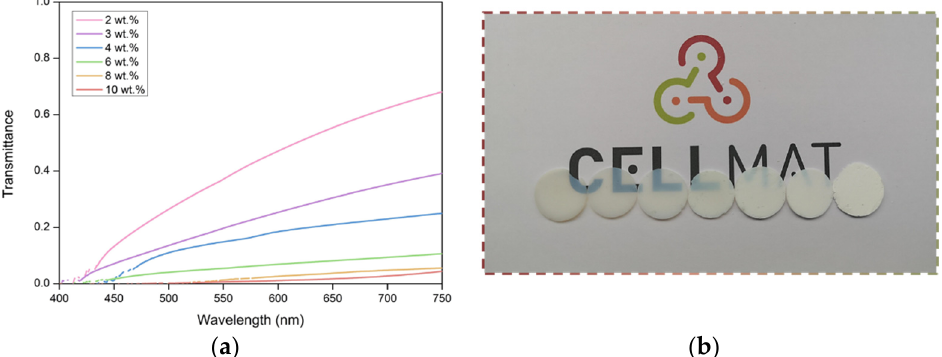
Figure 7. ( a ) UV–Vis transmittance measurements for all the samples under study. Measurement corrected for samples of 1 mm. ( b ) Optical micrographs of the samples from left to right; catalyst content and particle size increase in the following order: 2 wt.%, 3 wt.%, 4 wt.%, 6 wt.%, 8 wt.%, 10 wt.%, and 18 wt.%.